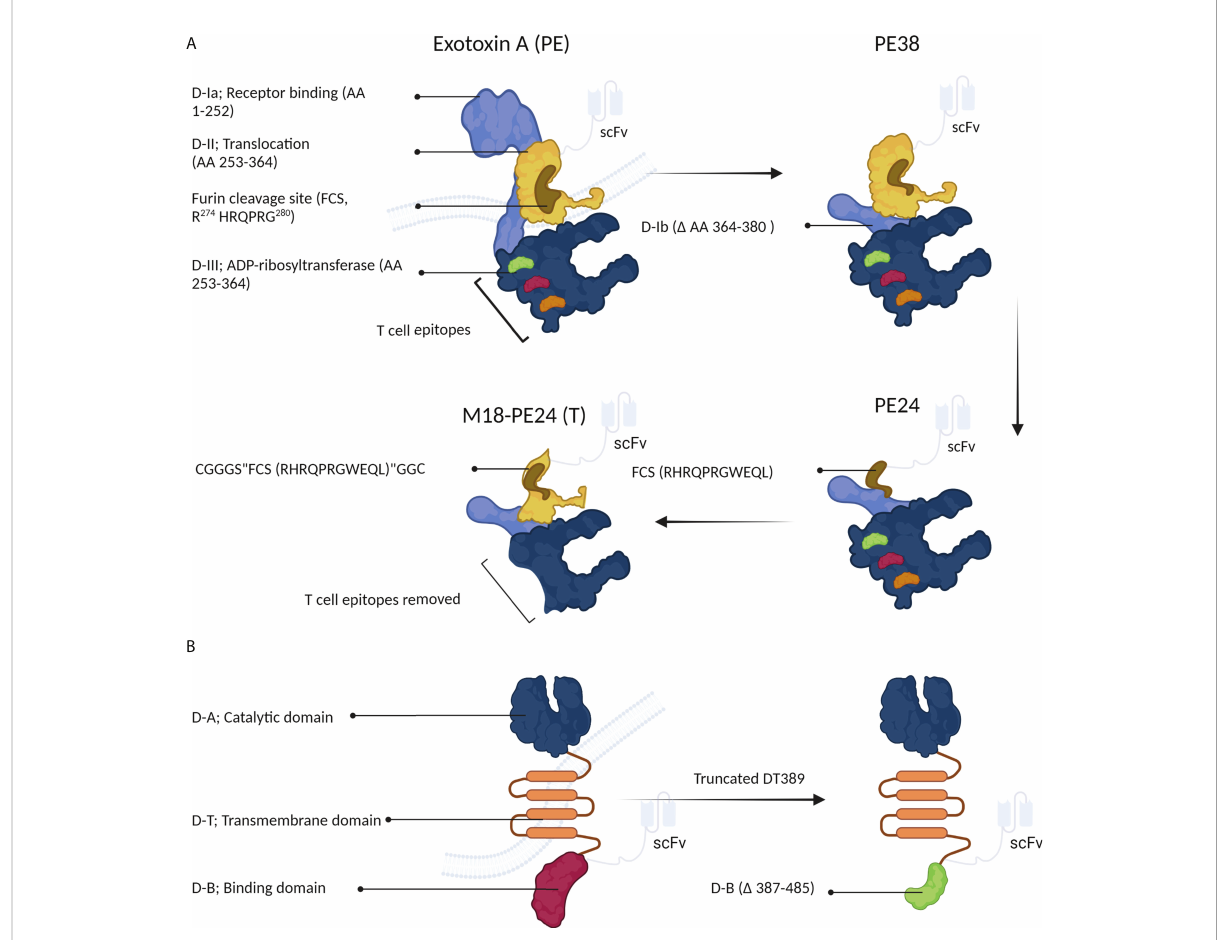
FIGURE 4 The structure of Pseudomonas exotoxin A (PE) and diphtheria toxin (DT). (A) PE can be manipulated to develop immunotoxins. (B) Structural changes in DT can increase its anticancer